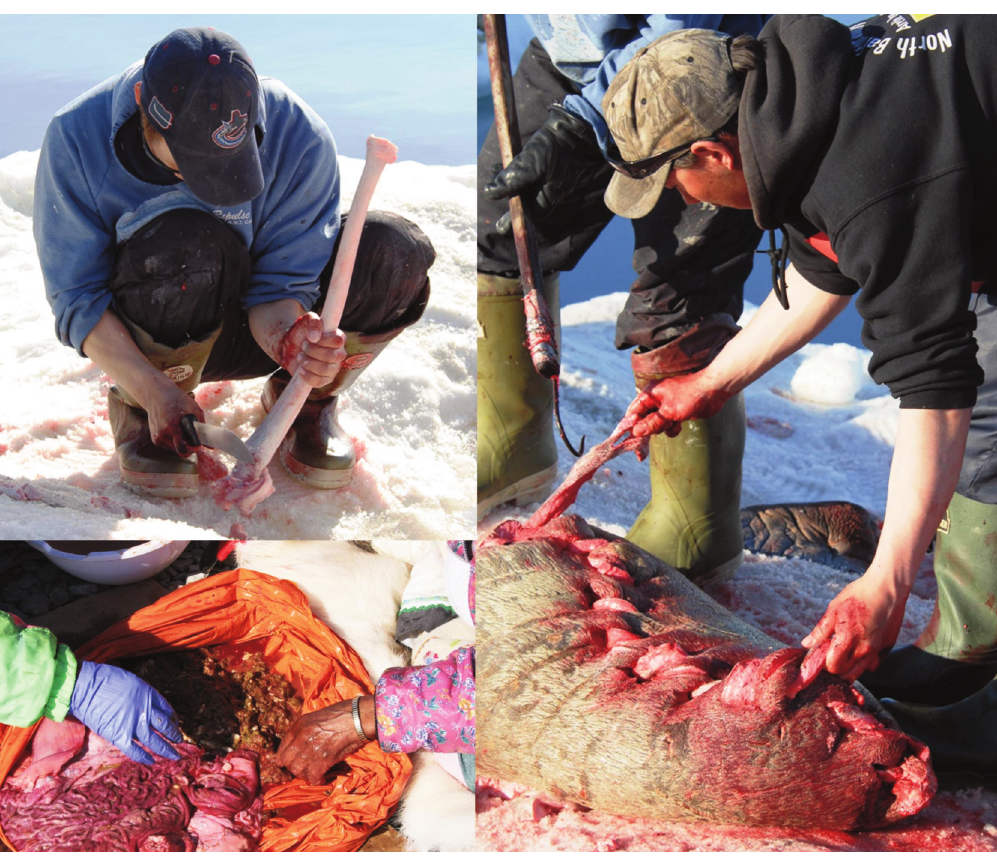
Fig. 9. Inuit cleaning the baculum (upper left), preparing igunak (right), and retrieving clams from the stomach (lower left) of a walrus taken near Igloolik in 2007 (credit: J.W.